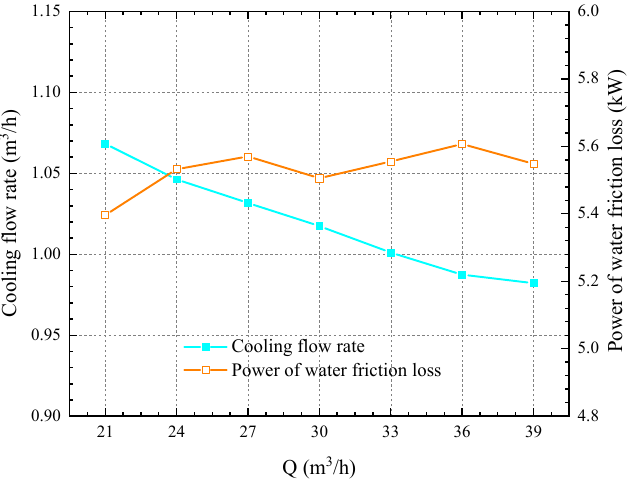
Figure 13. Comparison of cooling flow rate and water friction loss of the original pump.